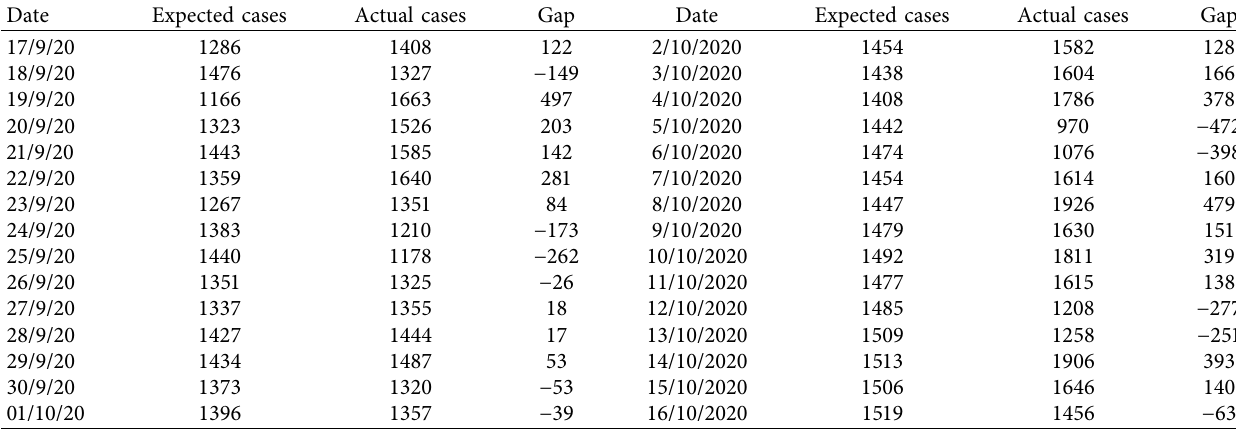
Table 10: The deviation between the actual and forecasted values of the daily confirmed COVID-19 cases in East Africa for the period between